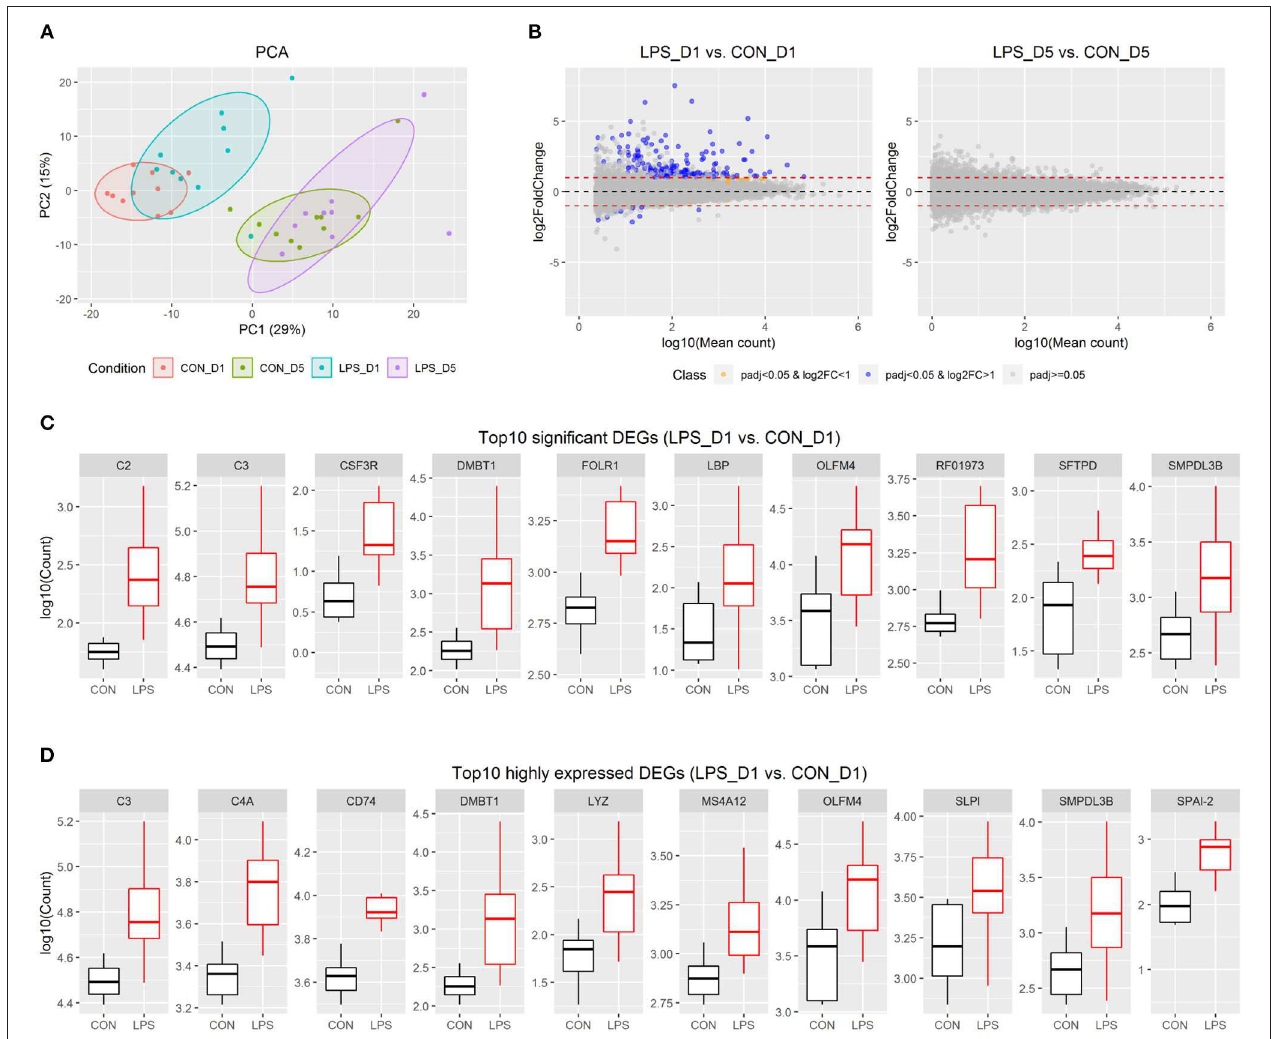
FIGURE 1 | Intestinal transcriptome profile in response to intra-amniotic LPS exposure. (A) Scores of the first two principle components from principal component analysis are plotted, with ellipses for the 80% confidence interval for each group. (B) MA plot showing fold change (LPS vs. CON) and mean of normalized counts for all the analyzed genes. (C) Boxplot of top 10 significant DEGs between LPS-D1 and CON-D1 groups. (D) Boxplot of top 10 highly expressed DEGs between LPS-D1 and CON-D1